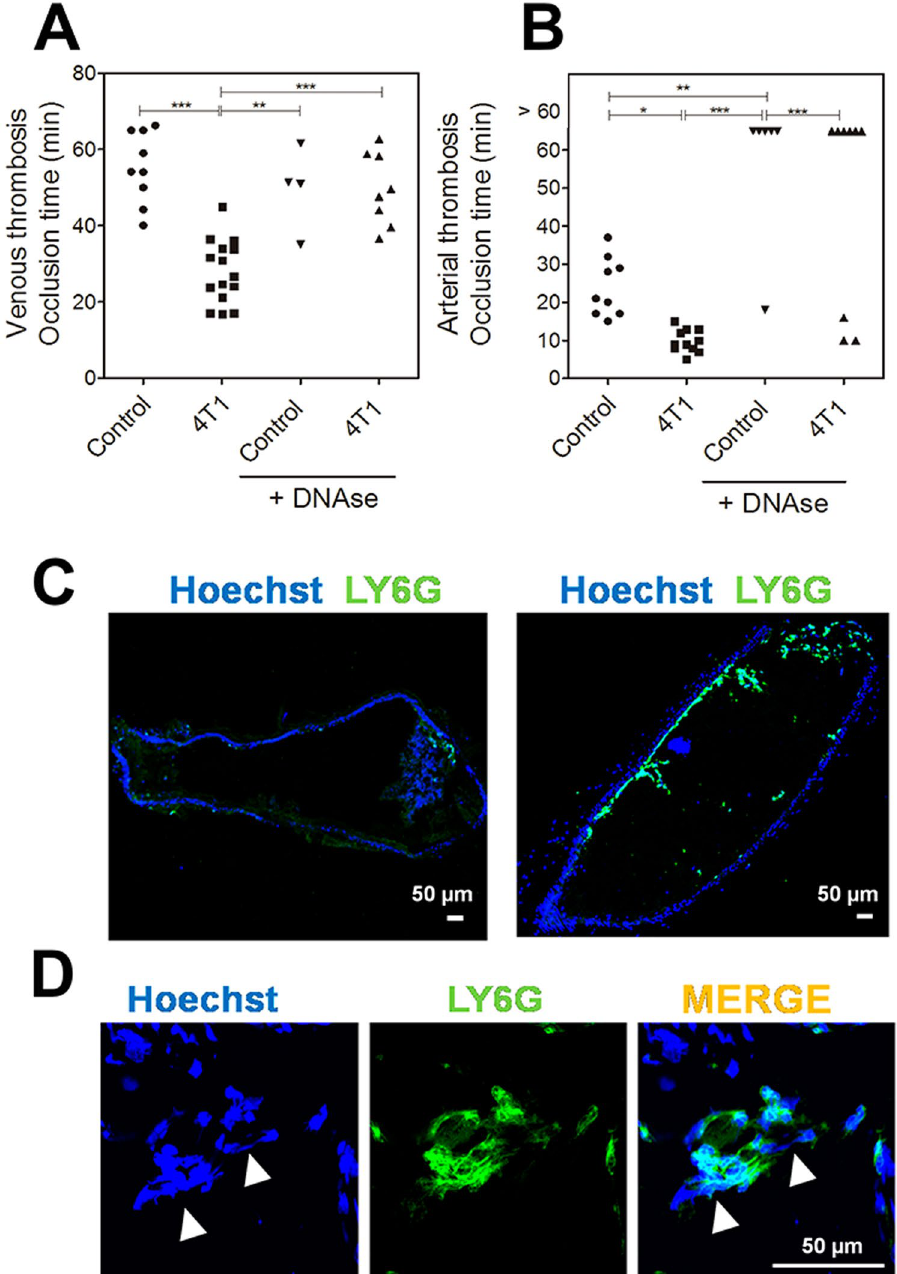
Figure 2. 4T1 tumor-bearing mice exhibit a NET-dependent prothrombotic state. ( A ) Venous thrombosis was evaluated in the Rose Bengal/laser-induced injury in control ( ● , n = 9) and 4T1 tumor-bearing ( ■ , n = 15) mice as described in the Methods section. Alternatively, control ( ▼ , n = 4) and 4T1-bearing ( ▲ , n = 8) mice were treated with DNase 1 (10 μ g, i.v.) 15 min before vessel injury. The data represent the occlusion time after photochemical injury in the jugular vein. ( B ) Arterial thrombosis was evaluated in the ferric chloride model in ( ● , n = 9) control and ( ■ , n = 9) 4T1 tumor-bearing mice as described in the Materials and Methods section. Alternatively, control ( ▼ , n = 6) and 4T1-bearing ( ▲ , n = 9) mice were treated with DNase 1 (10 μ g, i.v.) 15 min before vessel injury. The data represent the occlusion time after ferric chloride injury in the carotid artery. Each data point represents one individual mouse. ** P < 0.01; *** P < 0.001; analysis of variance (ANOVA) with Tukey’s posttest. ( C ) Fluorescence microscopy analysis of longitudinal cryosections of arterial thrombi from control (left) and 4T1 tumor-bearing mice (right). ( D ) Higher magnification of the thrombus from a 4T1 tumor-bearing mouse. The sections were stained with anti-Ly6G (green) and Hoechst (blue). Extracellular DNA fibers are indicated by arrows. Bars = 50 μ